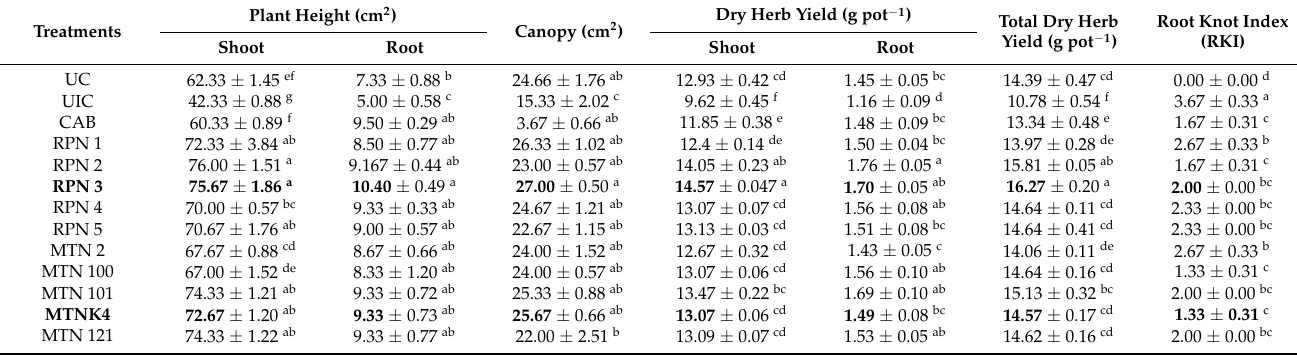
Table 2. Preliminary screening and impact of selected bacterial isolates on growth parameters of O. basilicum.